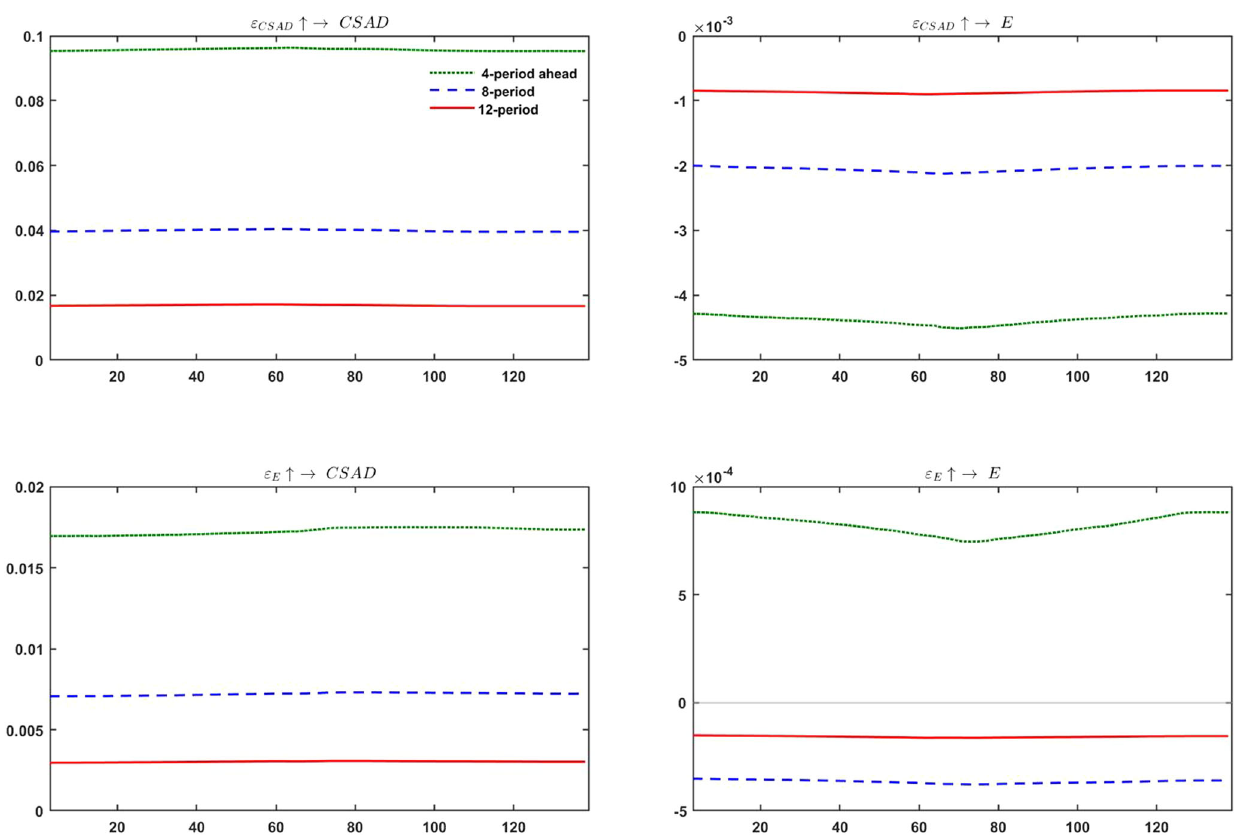
Fig. 2 Impulse responses in different ahead periods. The long-, medium- and short-term responses of market dispersion and internet postings to a unit